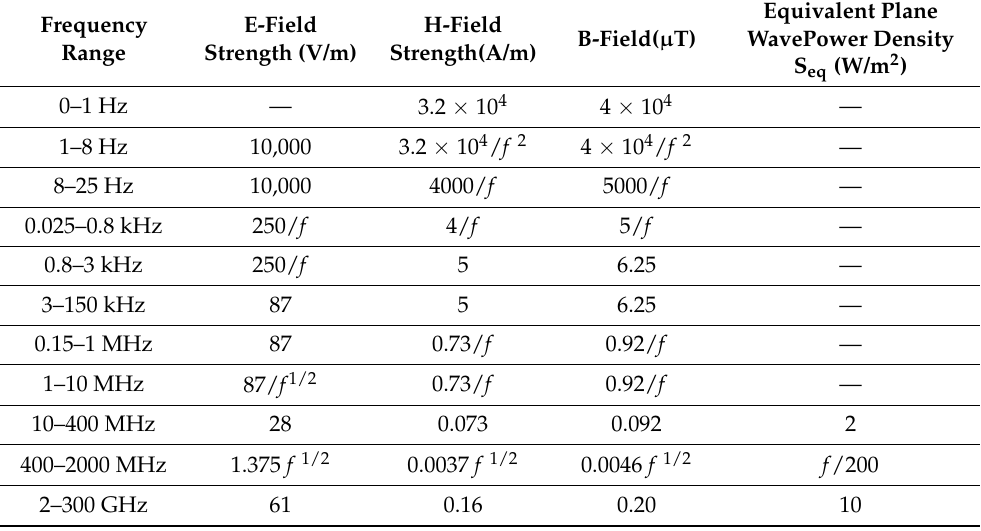
Table 2. European Recommendation 1999/519/EC—Reference levels for electric, magnetic and electromagnetic fields (0 Hz to 300 GHz, unperturbed RMS